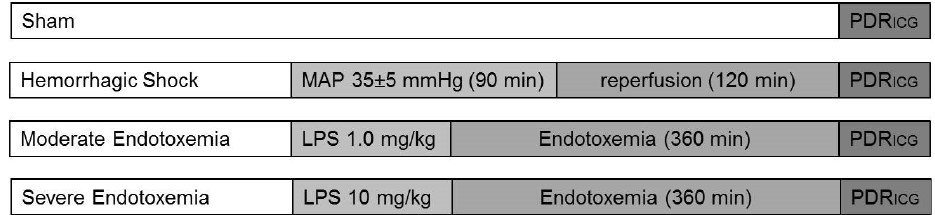
Figure 1. Experimental protocol. The plasma disappearance rate of indocyanine green (PDR ICG ) was assessed in all groups, either after the sham operation, after the hemorrhagic shock, or after moderate or severe endotoxemia. LPS = lipopolysaccharide.